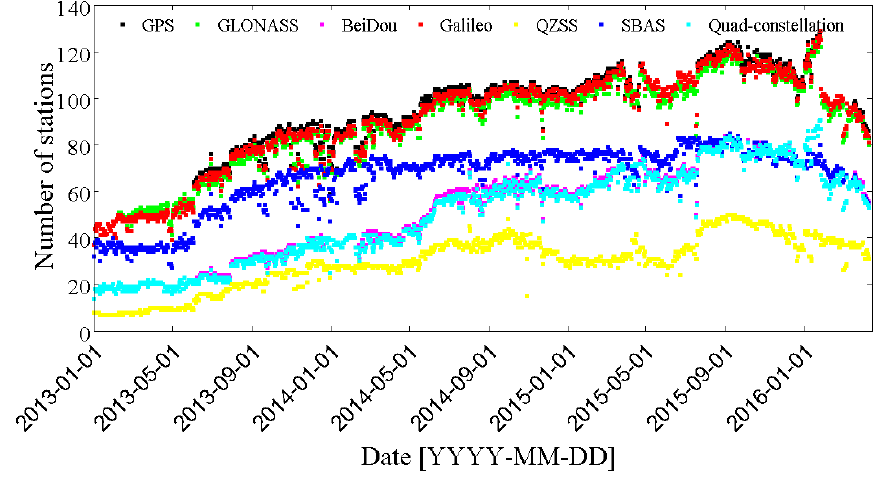
Figure 1. Number of MGEX ground tracking stations.